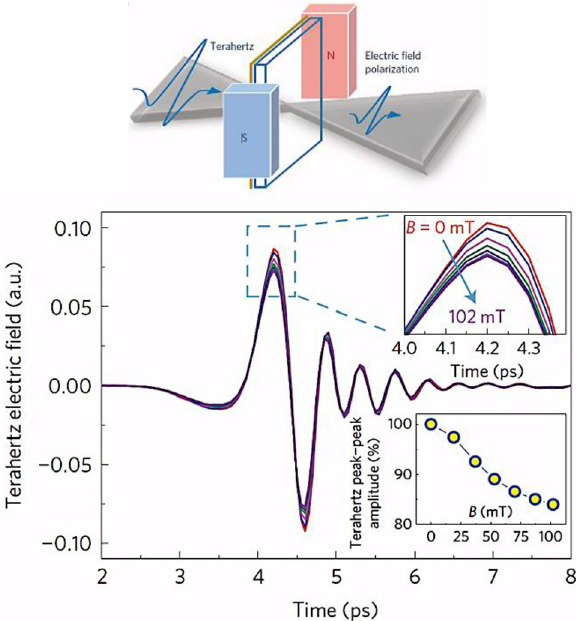
Figure5: Terahertzmagnetospectroscopyexperimentshowing20% magnetic modulation. Schematic of the terahertz magnetospectroscopy experimental setup. The polarization of the electric field of the terahertz pulse and that of the applied magnetic field arein theplane of the sample.Transmitted terahertzpulseas a functionof appliedmagneticfieldforaNiCoFe/CuGMRmultilayer.A reduction of the pulse amplitude by 20% is clearly observed (see lower inset). Reprinted by permission from Springer Nature: Springer Nature, Nature Physics, Accessing the fundamentals of magnetotransport in metals with terahertz probes, Zuanming Jin et al, [42] Copyright